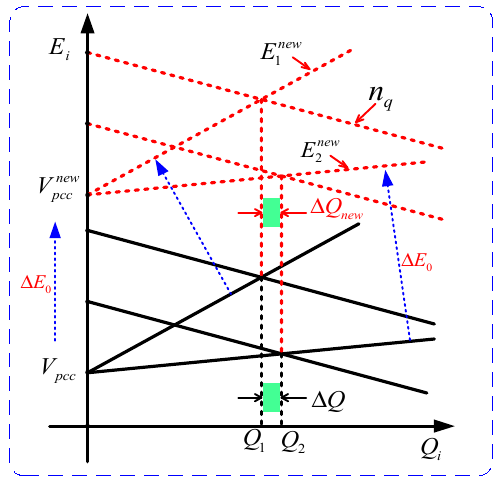
Figure 4. Schematic diagram of the voltage recovery mechanism.